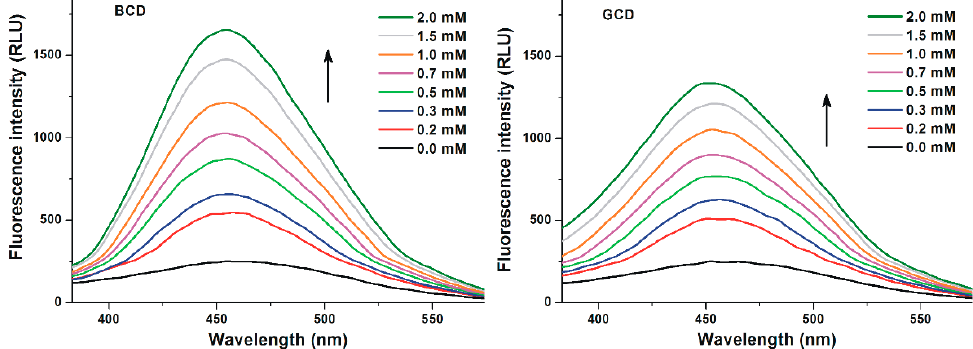
Figure 3. Fluorescence emission spectra of Z14G (1 µM) in the presence of increasing BCD (left) and GCD (right) concentrations (0.0–2.0 mM) in 0.05 M sodium acetate buffer (pH 5.0; λ ex = 315 nm).